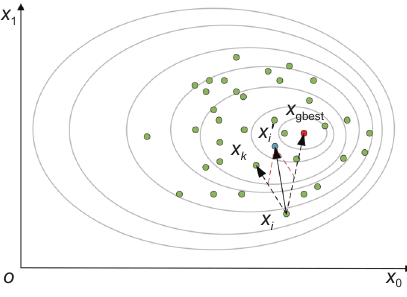
Fig. 4 Illustrations of excellent example learning